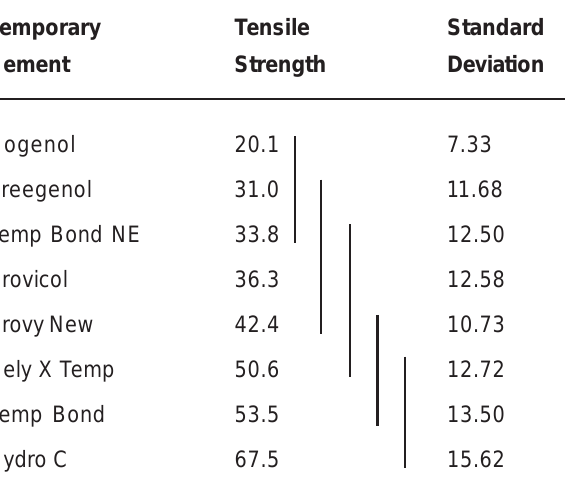
TABLE 1 - Mean values (in Newtons) for tensile strength and standard deviations for each